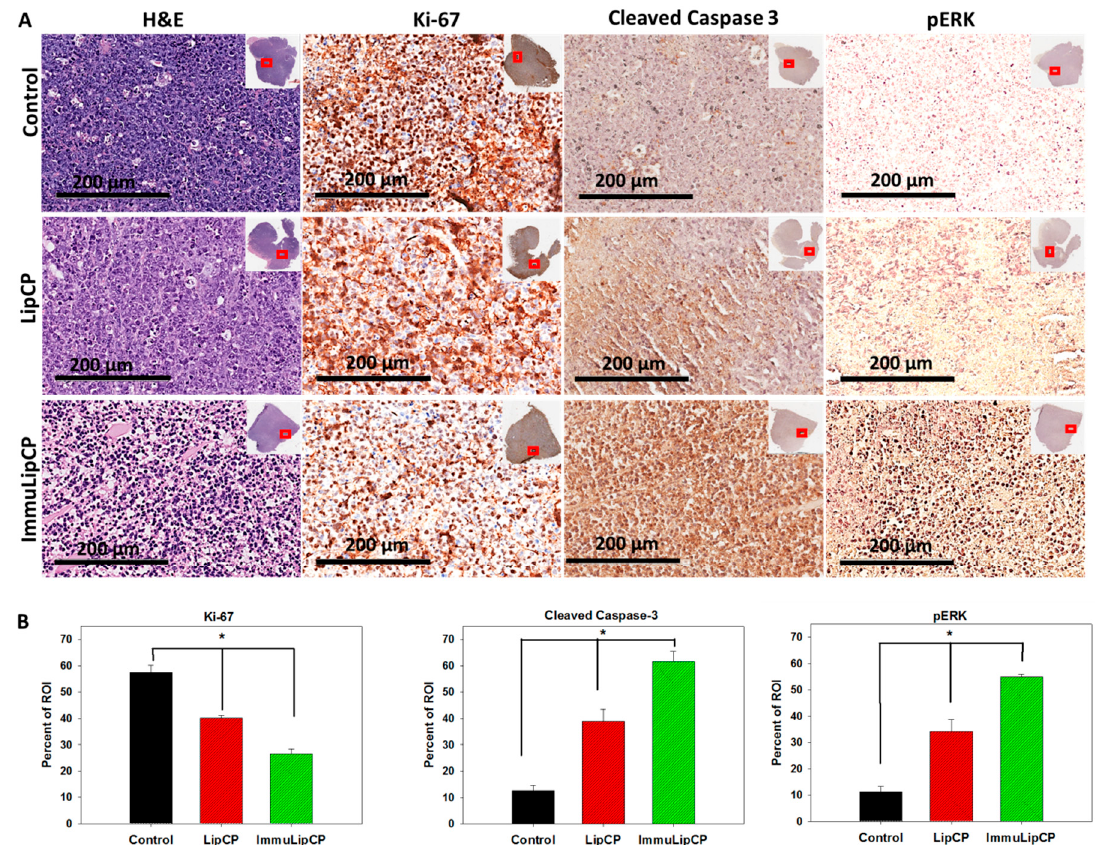
Figure 11. ( A ) The H&E and immunohistochemical (IHC) staining of Ki-67, cleaved caspase 3 and pERK after treatment with PBS (control), LipCP and ImmunLipCP (bar = 200 µ m). The image was an enlarged view of the red square shown in the insert for each tumor section. ( B ) The quantitative analysis of IHC staining results ( n = 5).